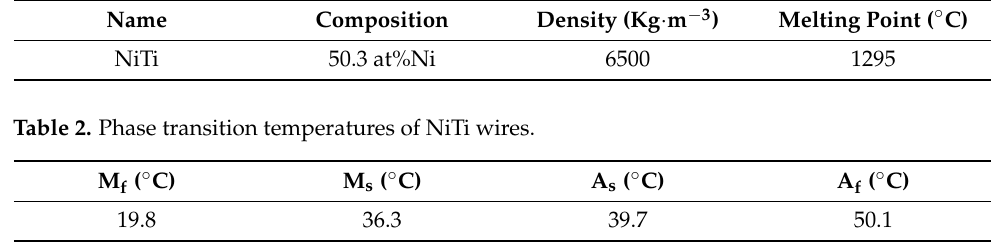
Table 1. Material properties of NiTi wires.